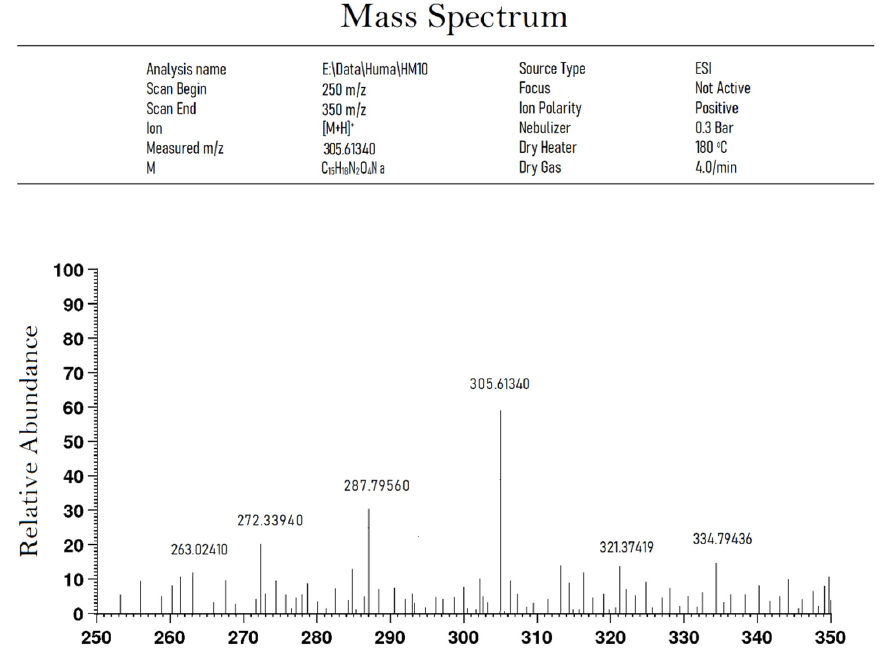
Figure 5. Mass spectrum of PH ‐ HM ‐ 10. Table 3. NMR ( 1 H and 13 C) chemical shifts value of